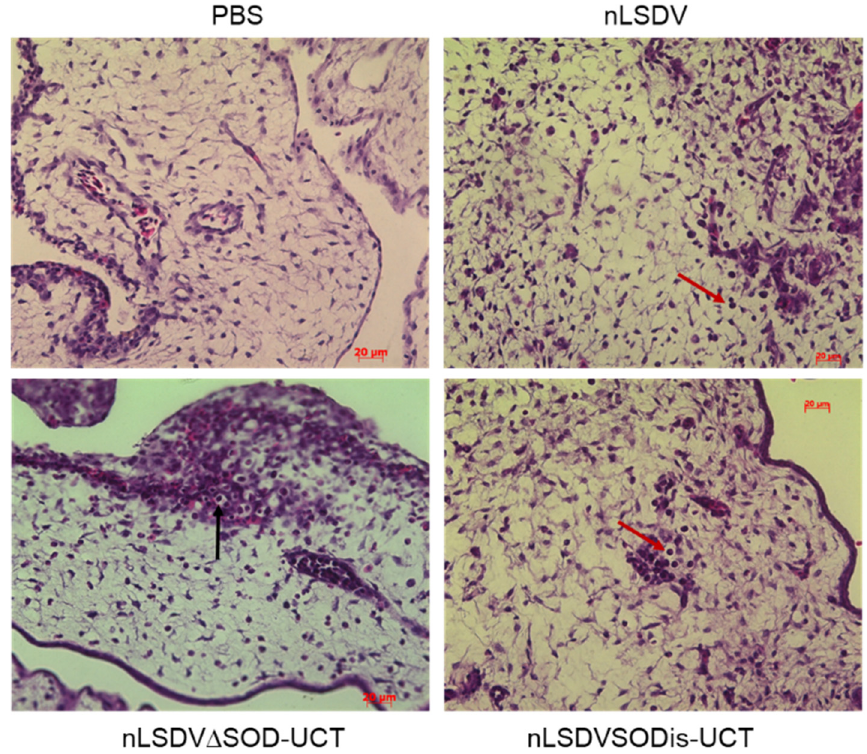
Figure 5. Histological analysis of infected CAMs. Hematoxylin and eosin (H&E) staining of fixed membranes 5 days post inoculation with PBS, nLSDV, nLSDV ∆ SOD-UCT and nLSDVSODis-UCT. Arrows indicate ballooning degeneration (black arrow) and white blood cell infiltration (red arrow); 400 × magnification. Table 1. Histology. Chorioallantoic membranes (CAMs) were inoculated with PBS, nLSDV, nLSDVdSOD-UCT and nLSDVSODis-UCT. Five days post infection, the CAMs were formalin fixed, and paraffin embedded sections were stained with H&E. Scoring was based on presence of intracytoplasmic inclusions, epithelial hyperplasia, and inflammatory changes.